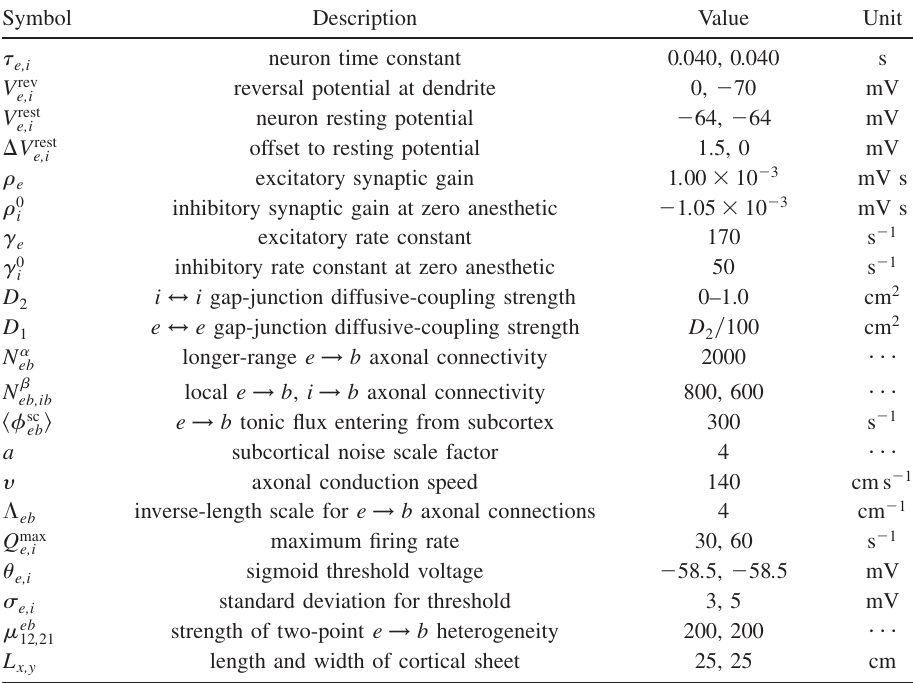
TABLE I. Symbol definitions and standard values for the cortical